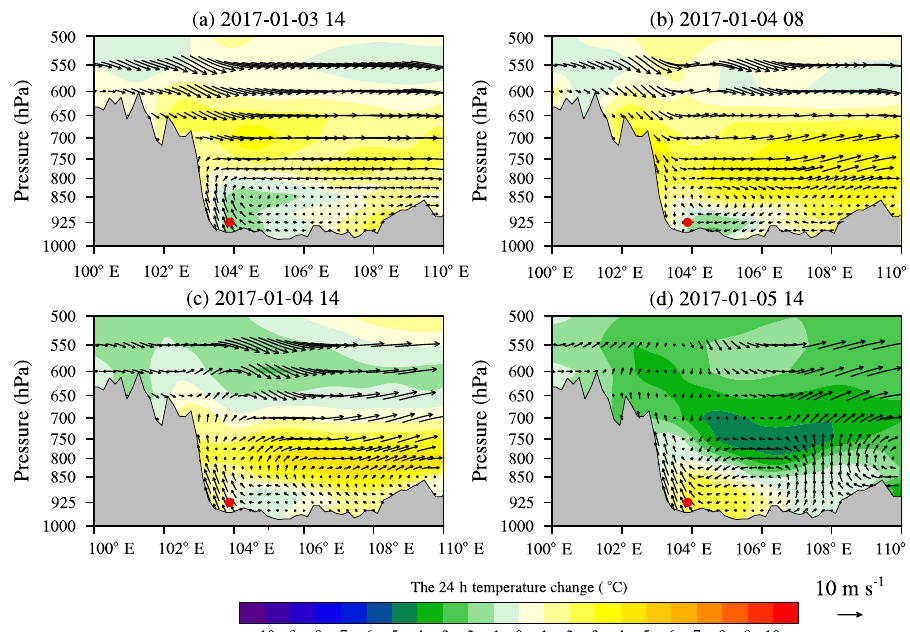
Figure 5. West–east vertical cross-sections of 24h temperature change (shading, units: ◦ C) and wind vectors (synthesized by u and w ) through the most polluted area (30.75 ◦ N) during event 8 at (a) 14:00BST on 3 January 2017, (b) 08:00BST on 4 January 2017, (c) 14:00BST on 4 January 2017 and (d) 14:00BST on 5 January 2017 during event 8. Note that the vertical velocity is multiplied by 100 when plotting the wind vectors. The most polluted area is marked by red solid dots. The gray shading represents the terrain.